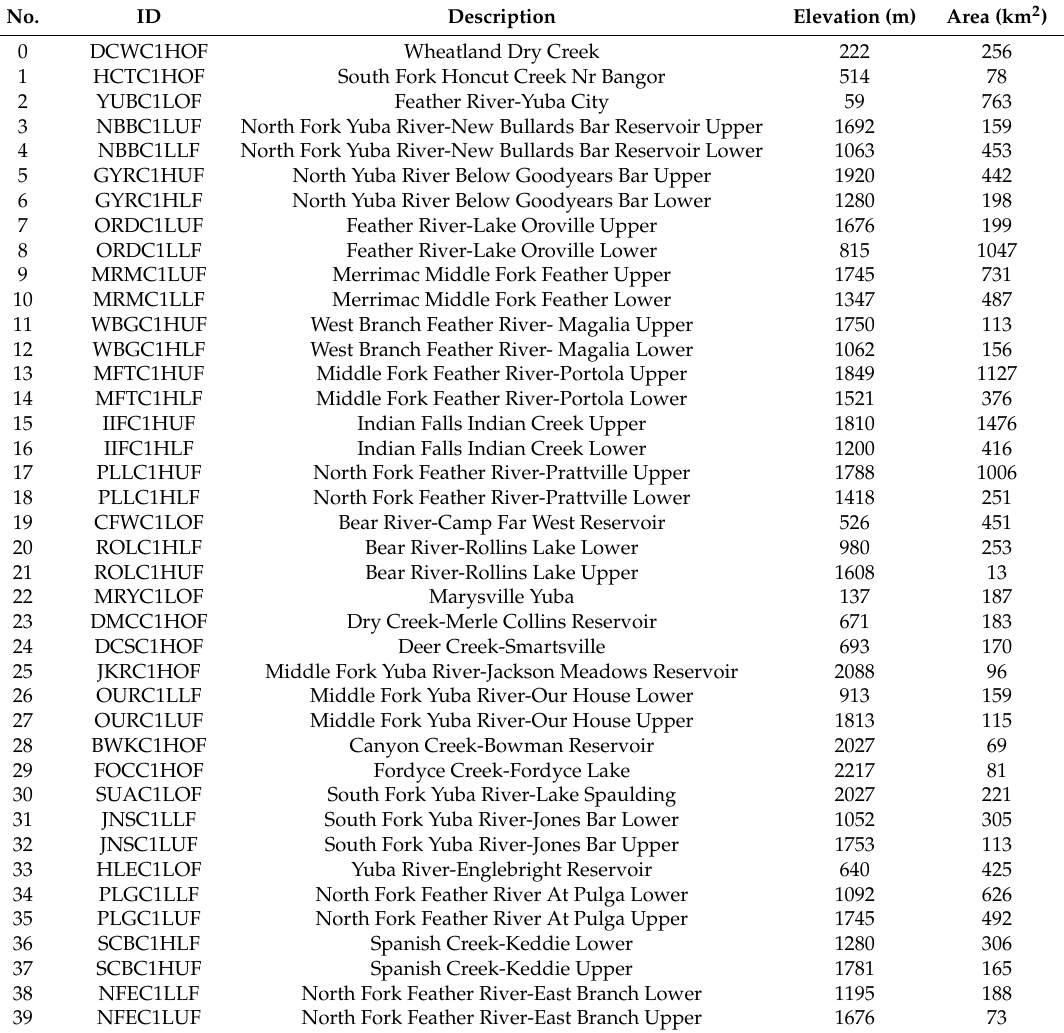
Table A2. Study basins in the Feather Yuba